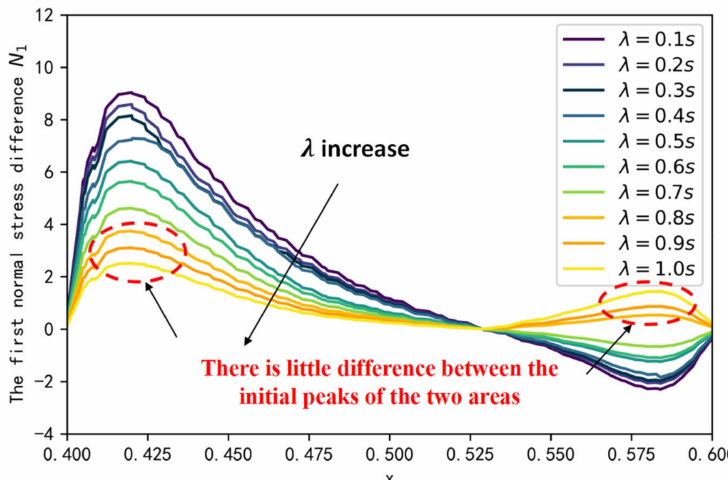
Figure 9. The first normal stress at the oil‑water interface for different λ .